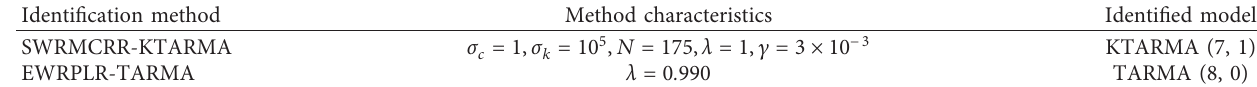
Table 1: Identification methods, their characteristics, and the identification models. Identification